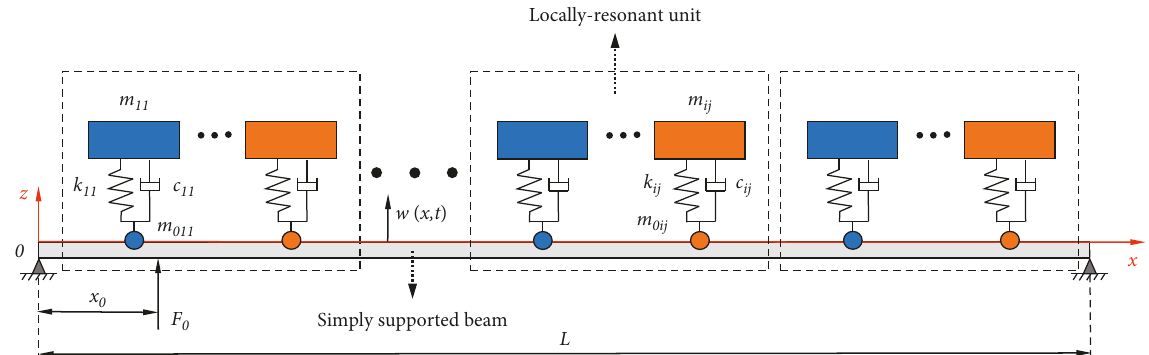
Figure 3: A simplified model of the finite locally resonant